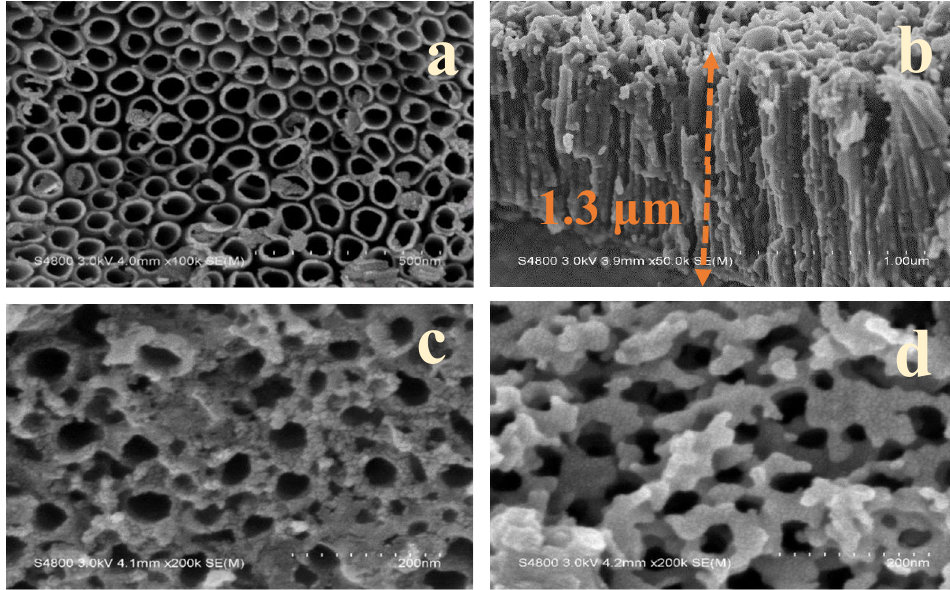
Figure 1. SEM images for ( a ) TNAs ( × 100 k), ( b ) cross-section image of TNAs ( × 50 k), ( c ) Fe/TNAs- 0.2 ( × 200 k), and ( d ) Fe/TNAs-0.5 ( × 200 k) (parentheses shows the